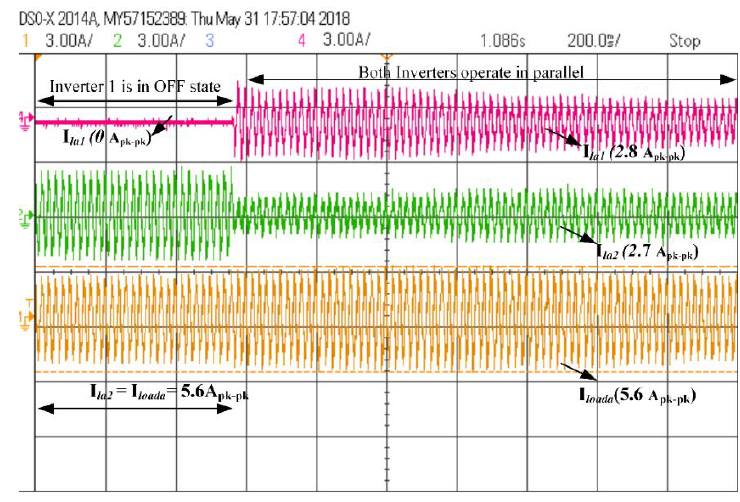
Figure 28. Transient operation of parallel inverters.